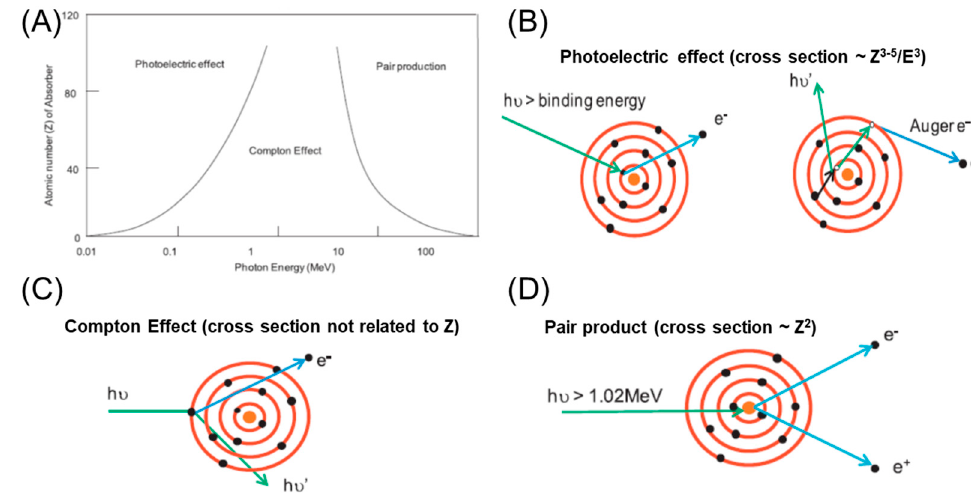
Figure 2. ( A ) Radiation energy and atomic number (Z) dependent interaction between radiation and Illustration of the ( B ) Photoelectric effect, ( C ) Compton Effect, and ( D ) pair production. ( B ) In the photoelectric effect (10–500 keV): the energy of the incident photon (h υ ) is fully absorbed by an electron in the inner shell of an atom, and the electron is ejected from the atom. The vacant orbit is filled with an electron from an outer shell with high energy; extra energy is either released as a photon or absorbed by another electron in an outer shell, which is ejected from the atom (Auger electron). This Auger effect occurs in cascade if there are multiple shells of electrons in the atom. ( C ) In the Compton Effect (500 keV–1.02 MeV): the energy of the incident photon is partially absorbed by an electron in the outer shell of an atom, and the extra energy is released as photons. ( D ) In Pair product: when the energy of an incident photon is at least two-fold larger than mec2 (>1.02 MeV), and the energy is fully absorbed by the nucleus of an atom, a pair of electrons and positrons are generated from the nucleus. Adapted with permission [39]. Elsevier, Copyright 2017.